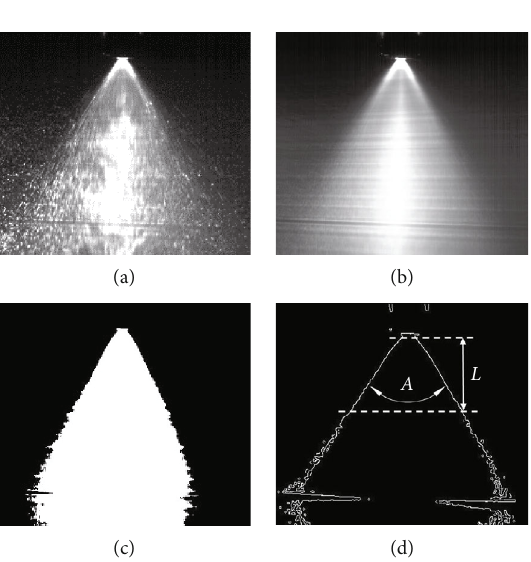
Figure 2: Postprocessing of images: (a) transient image; (b) average-time image; (c) binary image; (d) boundary of